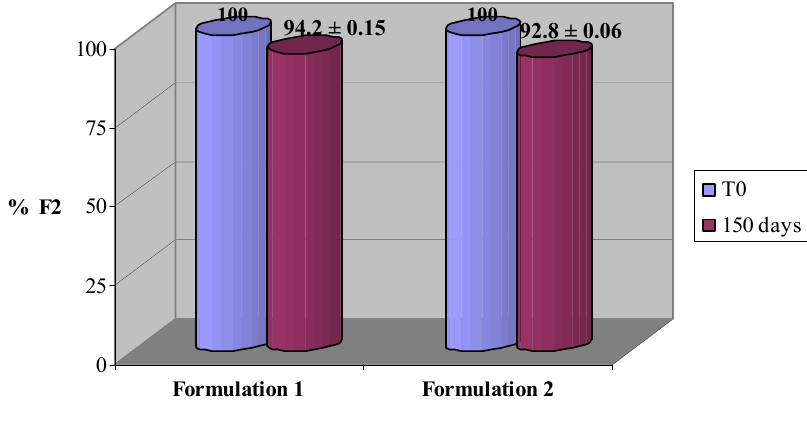
Figure 5. F2 recovery in the different formulations stored at 40 °C. Each value was obtained from three experiments (Mean ±